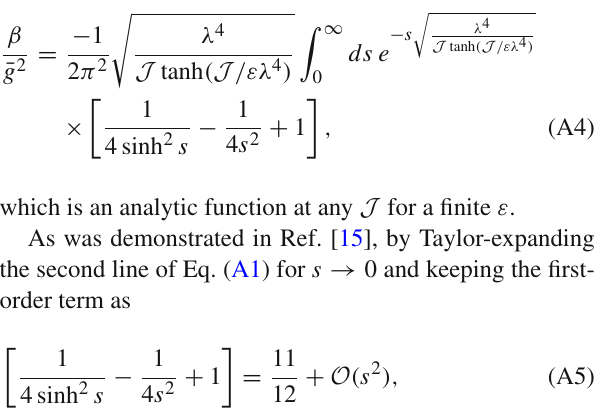
Fig. 5 The ratio of the one-loop β -function coefficient β ( 1 ) / ¯ g 2 ( the corresponding all-loops quantity given in Eq. (A4) ( ε = 0 . 01)